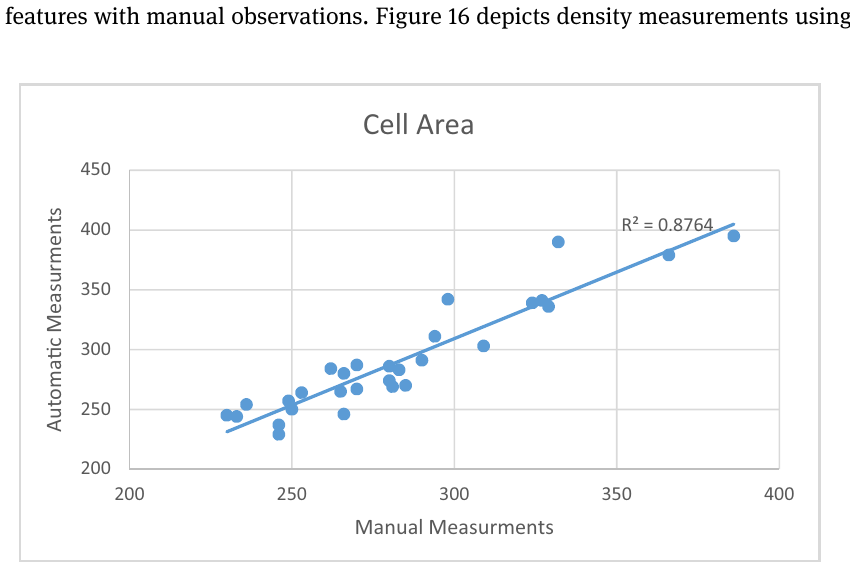
Figure 17: Correlation for the cell area feature for the segmented